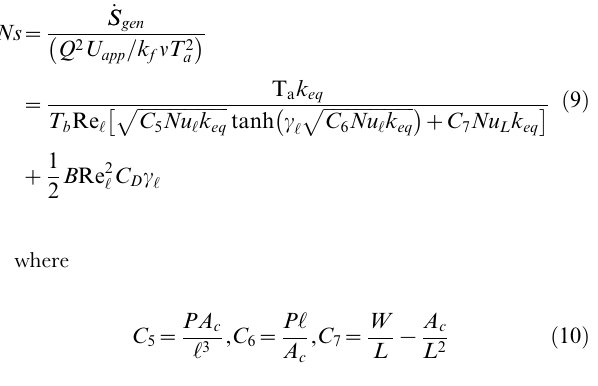
ffiffiffiffiffiffiffiffiffiffiffiffiffiffiffiffiffiffiffiffi C p tanh c 5 Nu ‘ k eq